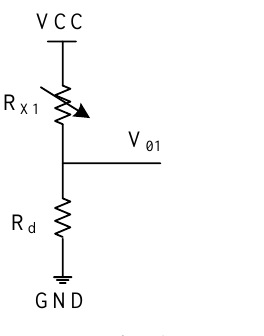
Figure 3. A fixed resistor grounding bleeder circuit.